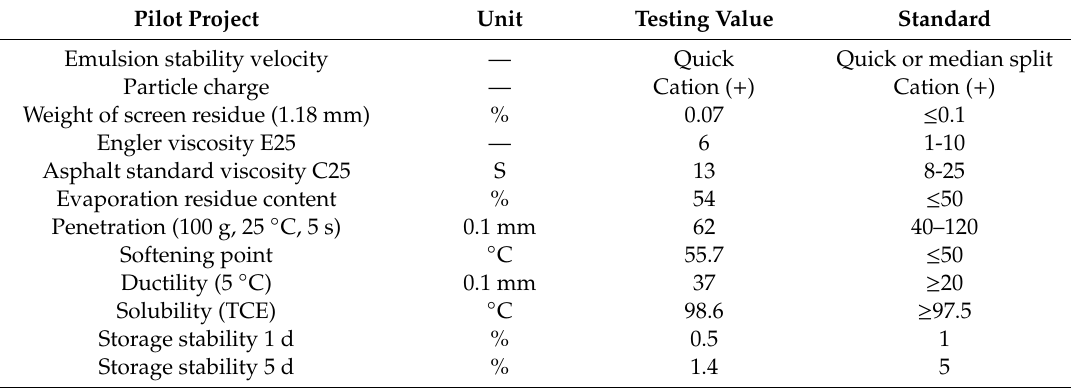
Table 2. Technical indices of SBS-modified emulsified asphalt.